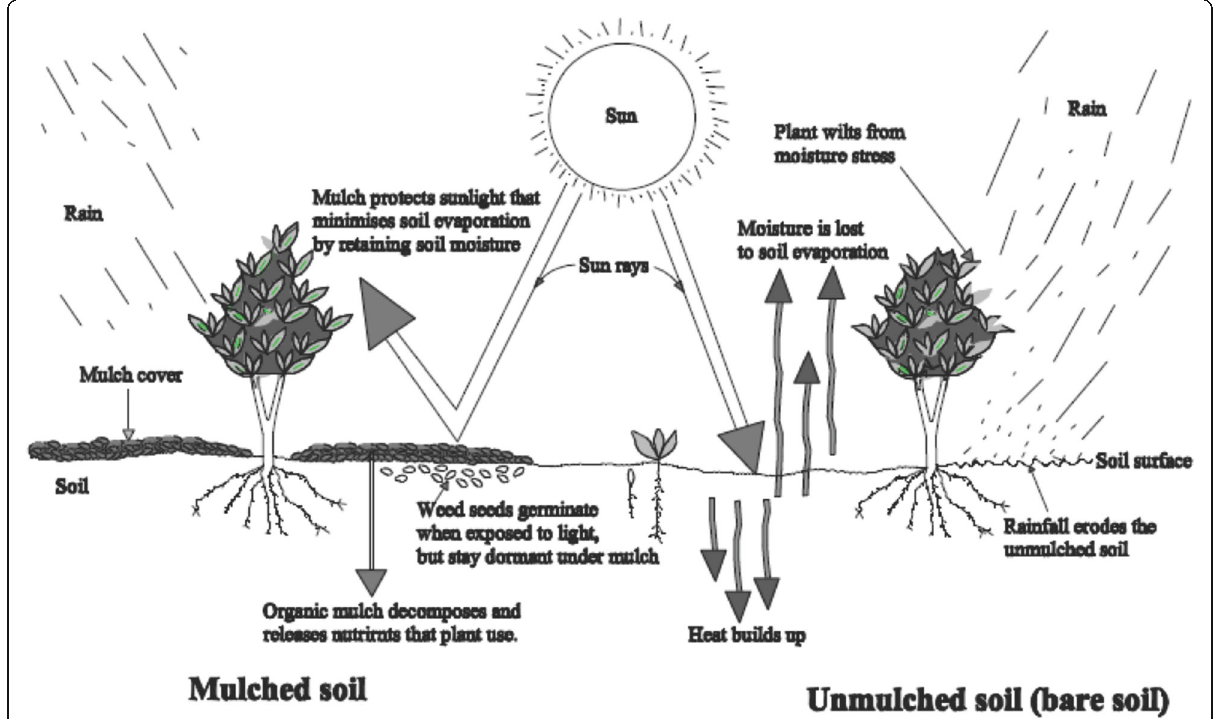
Fig. 2 Advantage of mulched and un-mulched soil interactions with plant and environments (Kader et al.